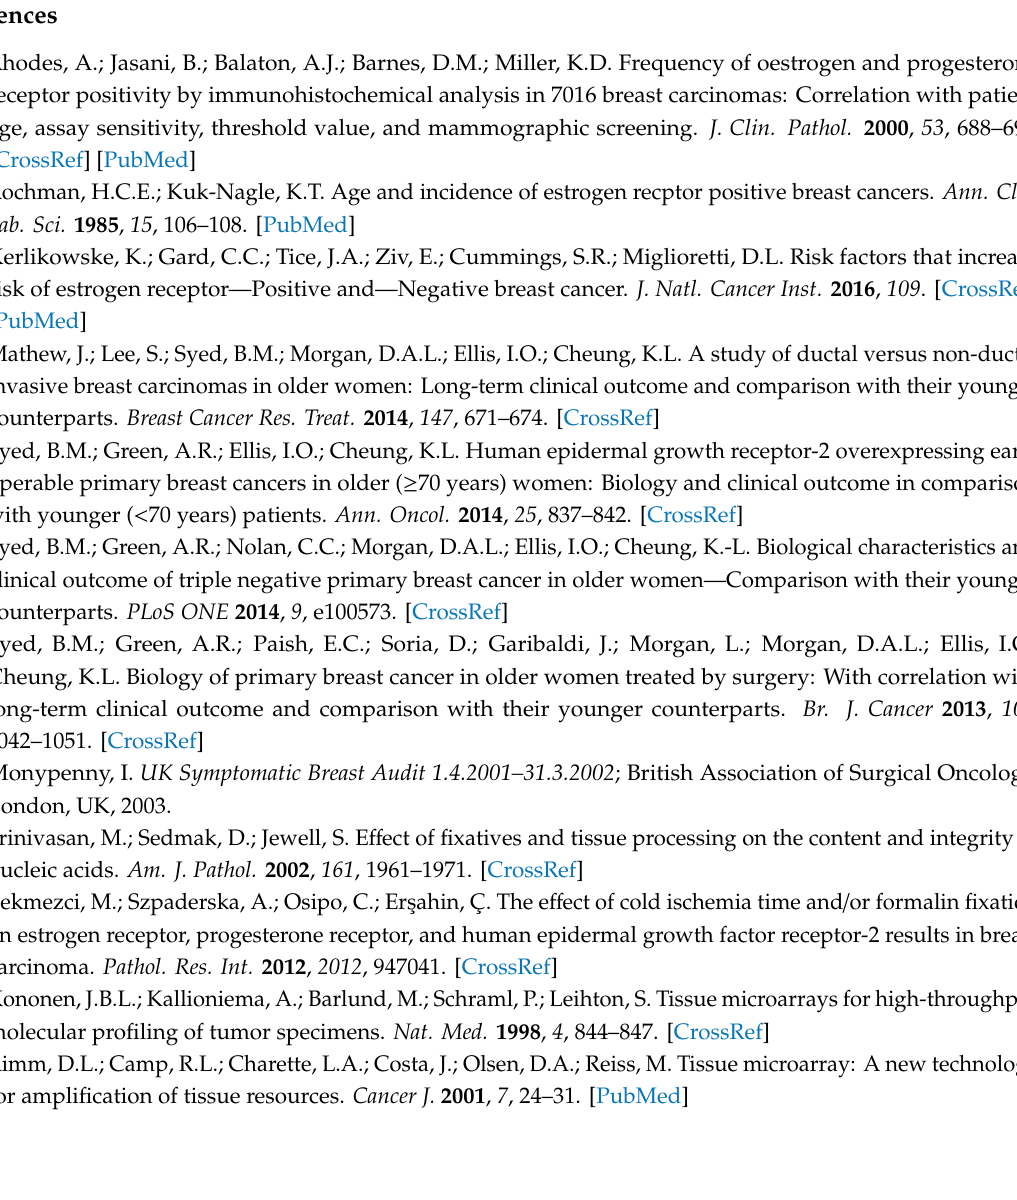
Figure S1: Representative H&E stains of constructed CNB TMA, Figure S2: Samples from CNB TMAs stained for PgR, Ki67 and p53, Figure S3: Relationship between PgR expression and BCSS (univariate analysis), Figure S4: Relationship between VEGF expression and BCSS (univariate analysis), Figure S5: Relationship between BCL2 expression and BCSS (univariate analysis), Figure S6: Relationship between Ki67 expression and BCSS (univariate analysis), Figure S7: Relationship between MUC1 expression and BCSS (univariate analysis), Figure S8: Relationship between p53 expression and BCSS (univariate